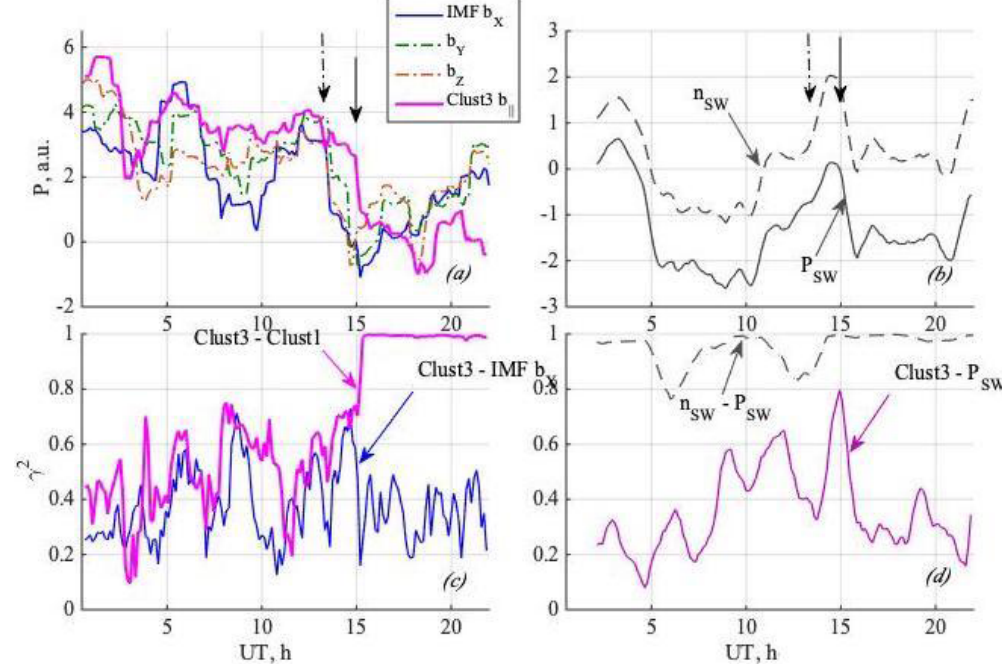
Figure 6. The left column shows time variations in (a) spectral power and (c) average spectral coherence for the three IMF components (GSM) and the field-aligned b || components from Cluster 1 and 3. The right column shows (b) variations in total spectral power and (d) average spectral coherence for the SW density and SW dynamic pressure as well as the field-aligned b || components from Cluster 3. The dot-dashed arrows indicate the time at which there is a significant decrease in the spectral power in the IMF fluctuations, and the solid arrows indicate the time at which there is a significant decrease in b || from Cluster 3 and the SW density and